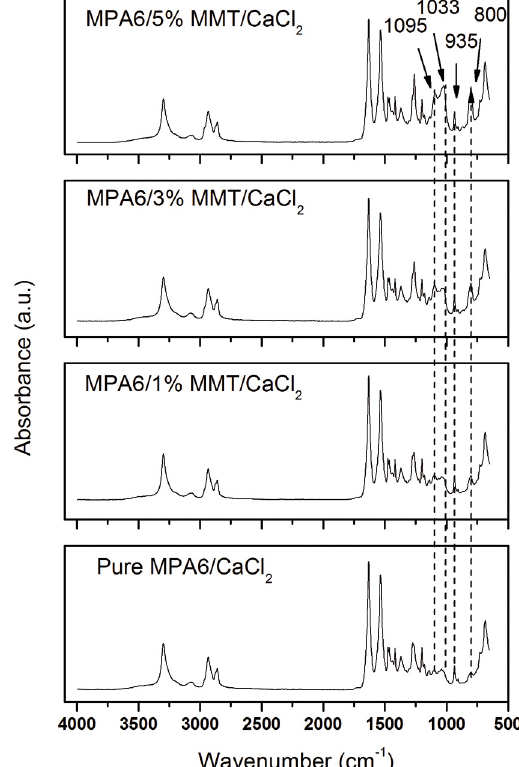
Figure 2. FTIR spectra of pure PA6 membranes and their hybrids 1, 3 and 5% w/w of MMT, adding 10% w/w of CaCl . 2